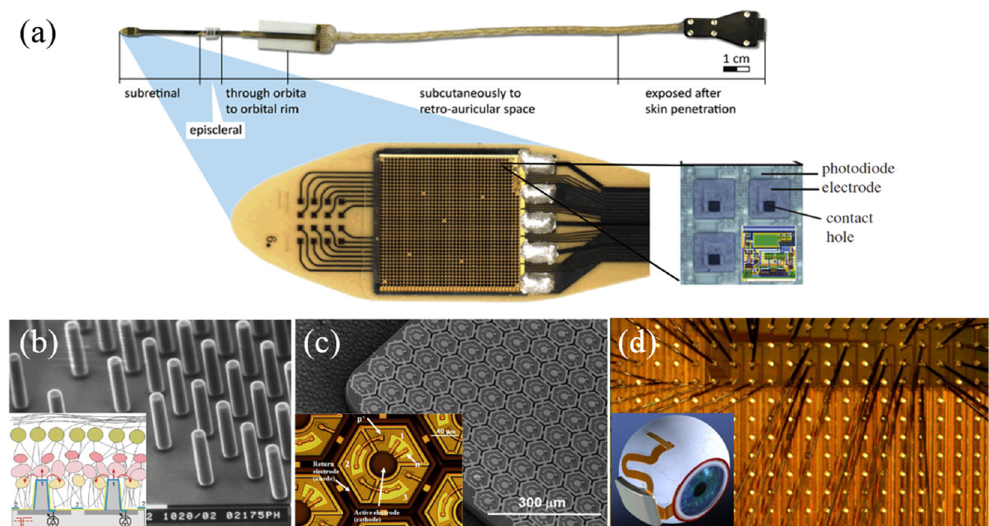
Figure 7. ( a ) The prototype of the Alpha-IMS predecessor, including 16 additional electrodes for direct stimulation. The microphotodiode array (MPDA) consists of 1500 photodiodes on a surface area of 3 × 3 mm [7] ; ( b ) SEM of the microfabricated SU-8 pillar arrays, each pillar is about 10 µm in diameter